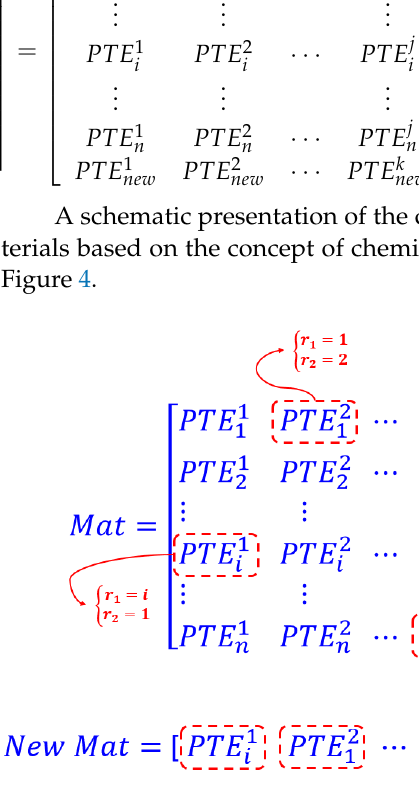
Figure 4. The schematic presentation of the random periodic table elements ( PTE ) selection and creating new materials.